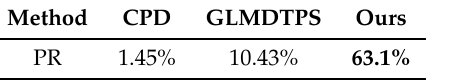
Table 1. Experimental results on series (i). Quantitative comparisons on the mean PR (precision ratio). Bold fonts indicate the best results. All units are in percentages. CPD (coherent point drift) denotes the method [29] and GLMDTPS (global and local mixture distance with thin plate spline transformation) denotes the method [30].